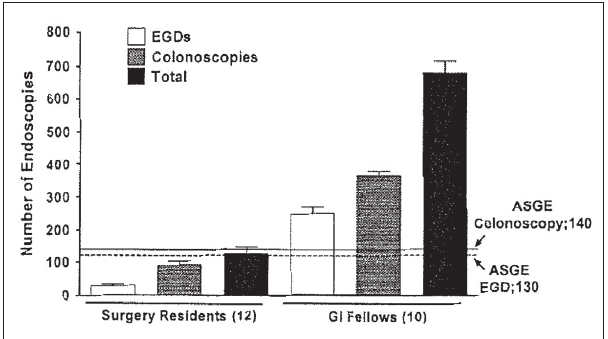
Figure 2) Gastroenterology (GI) fellows versus surgical residents on achieving minimum numbers. ASGE American Society for Gastrointestinal Endoscopy; EGD Esophagogastroduodenoscopy. Reproduced with permis- sion from reference 2